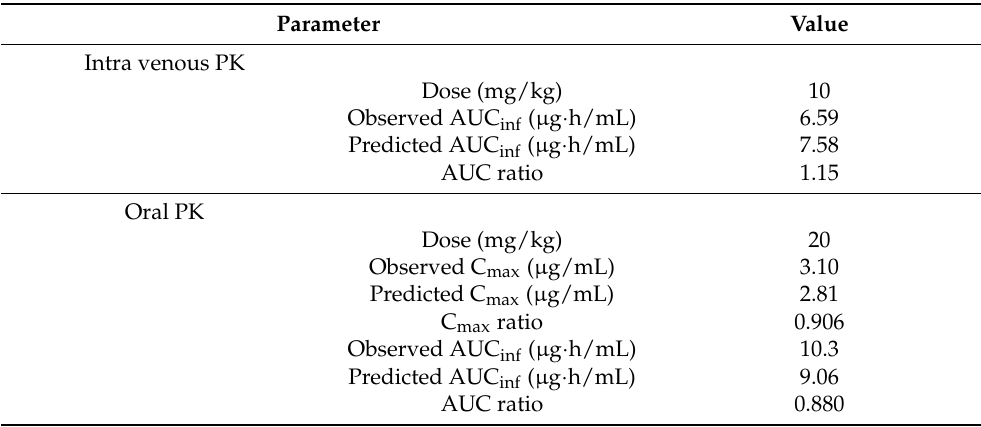
circles ( • ) represent observed data. Observed data are means ± SD ( n = 3 mice for intravenous administration study, n = 4 mice for oral administration study). Table 4. Observed and predicted PK parameters of IDP-73152 in mice.